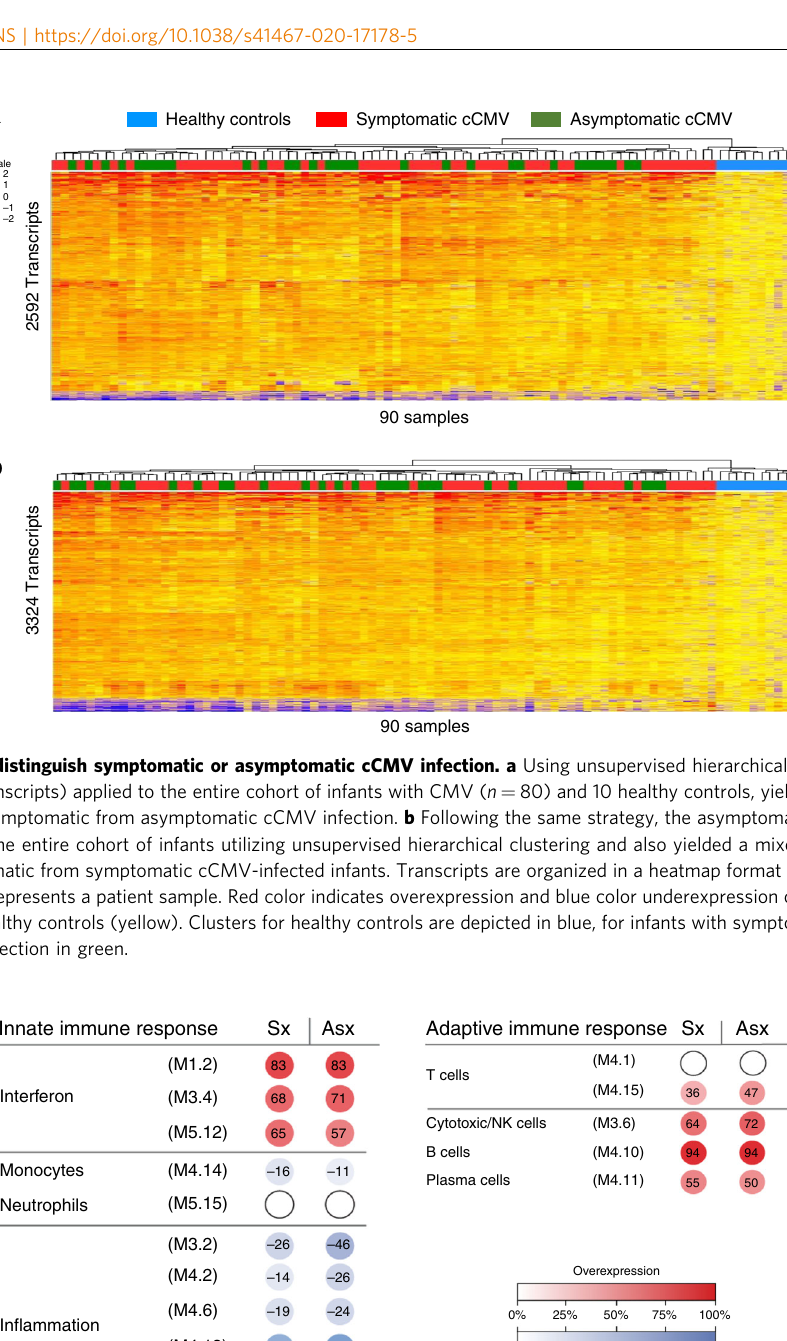
MDTH scores were observed between symptomatic or asymp- tomatic cCMV-infected infants (Fig. 4). sample obtained at follow-up visits at one, two, or three years of age. To be able to map changes in initial gene expression over time, the symptomatic (2592 transcripts; Fig. 5a) and asympto- matic (3324 transcripts; Fig. 5b) cCMV biosignatures were